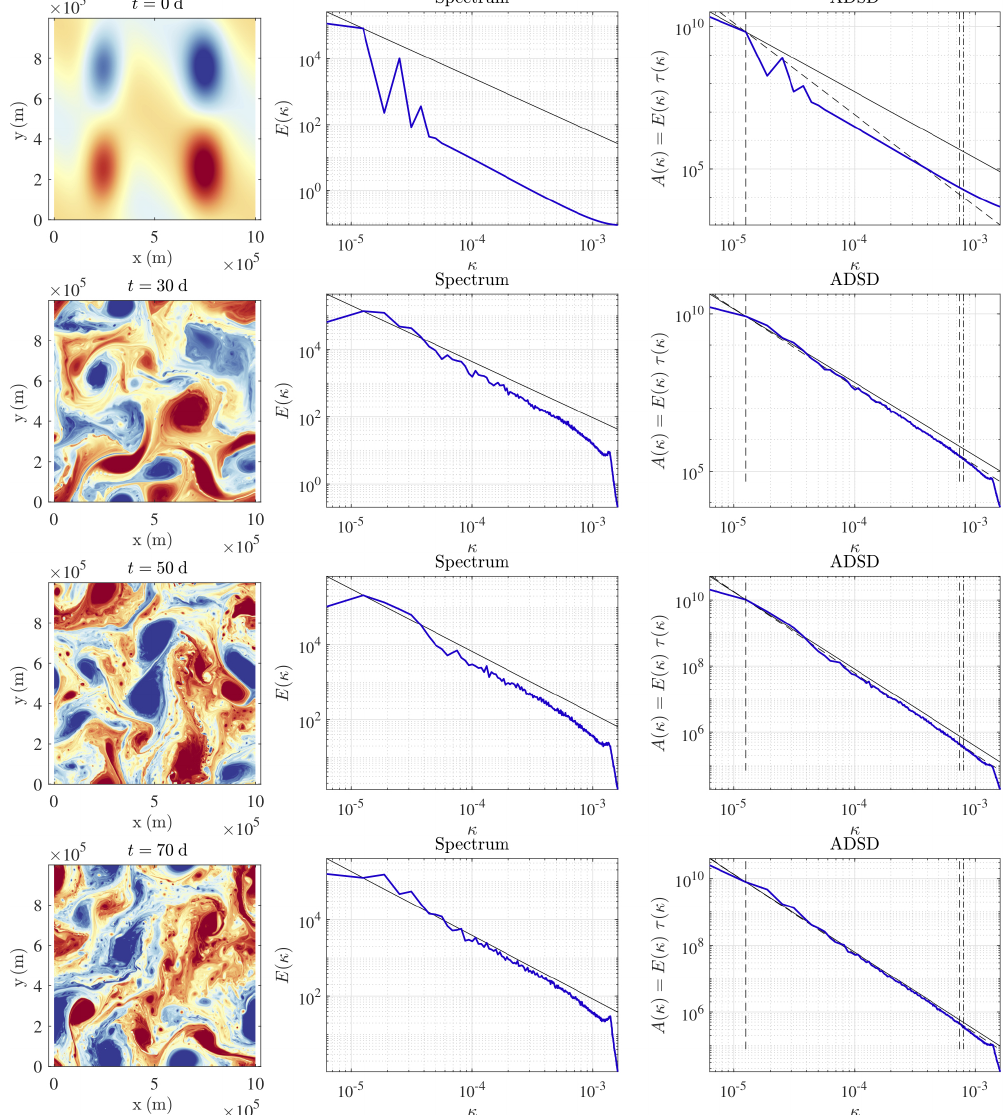
Figure 5. Buoyancy (ms − 2 ) (left), KE spectrum (m 2 s − 2 / (radm − 1 )) (middle), and ADSDs (m 2 s − 1 / (radm − 1 )) (right) at t = 0, 30, 50 and 70d of advection, for the deterministic SQG model at a resolution of 512 2